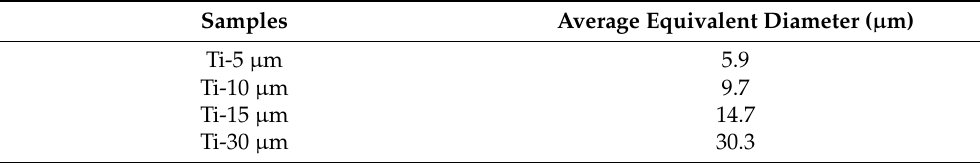
Table 1. Average equivalent diameters for each class of particles studied.